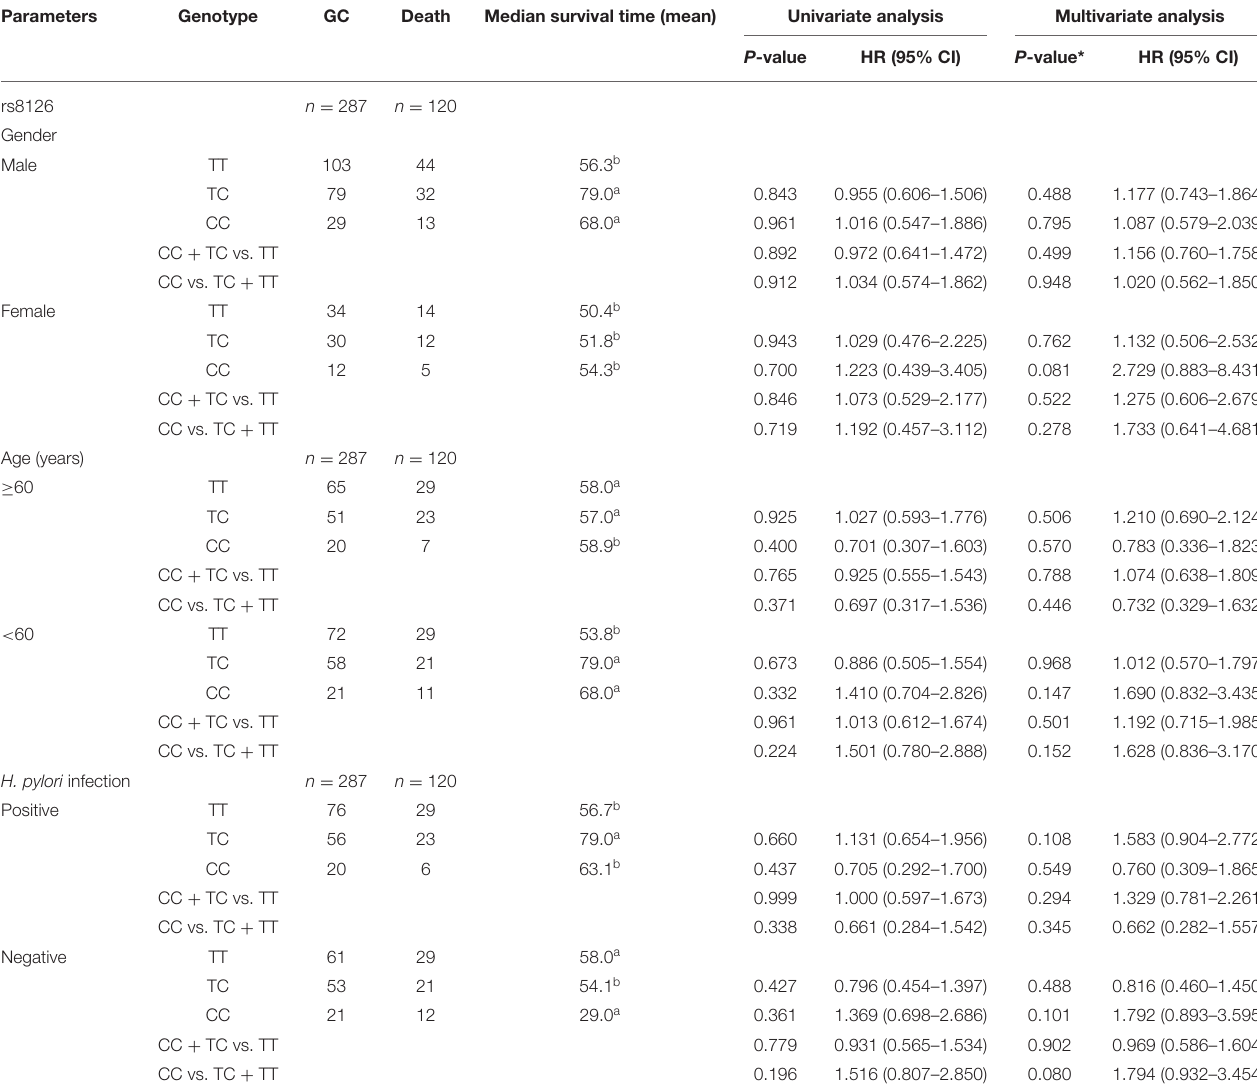
TABLE 7 | The correlation between TNFAIP2 rs8126 polymorphism and gastric cancer (GC) prognosis in the subgroup analysis.